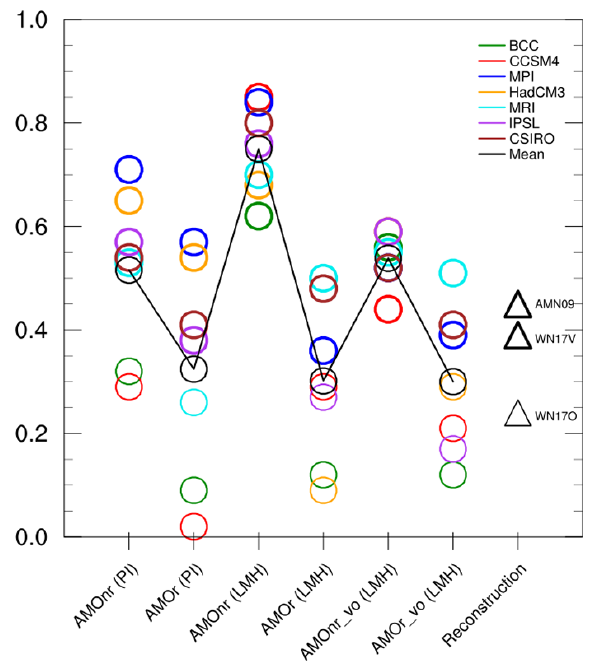
Figure 4. Correlations of annual-mean East Asian regional average surface temperature against AMO for each GCM (circles) for PI and LMH experiments compared with reconstructions (triangles). The mean correlations for the seven GCMs are marked with black circles connected by a solid line. AMOnr and AMOr are the two definitions of AMO index described in Fig. 1, while “vo” indicates that the volcanic influence on East Asian temperature has been re- moved by linear regression in the LMH experiments. The thick cir- cles and triangles show values significant at 95% level using a two- tailed Student’s t test. The reconstruction correlations are between the WN18 East Asian temperature and the three AMO reconstruc- tions (Table 2; the correlation with WN17O is weak (0.24) because it represents only internal AMO